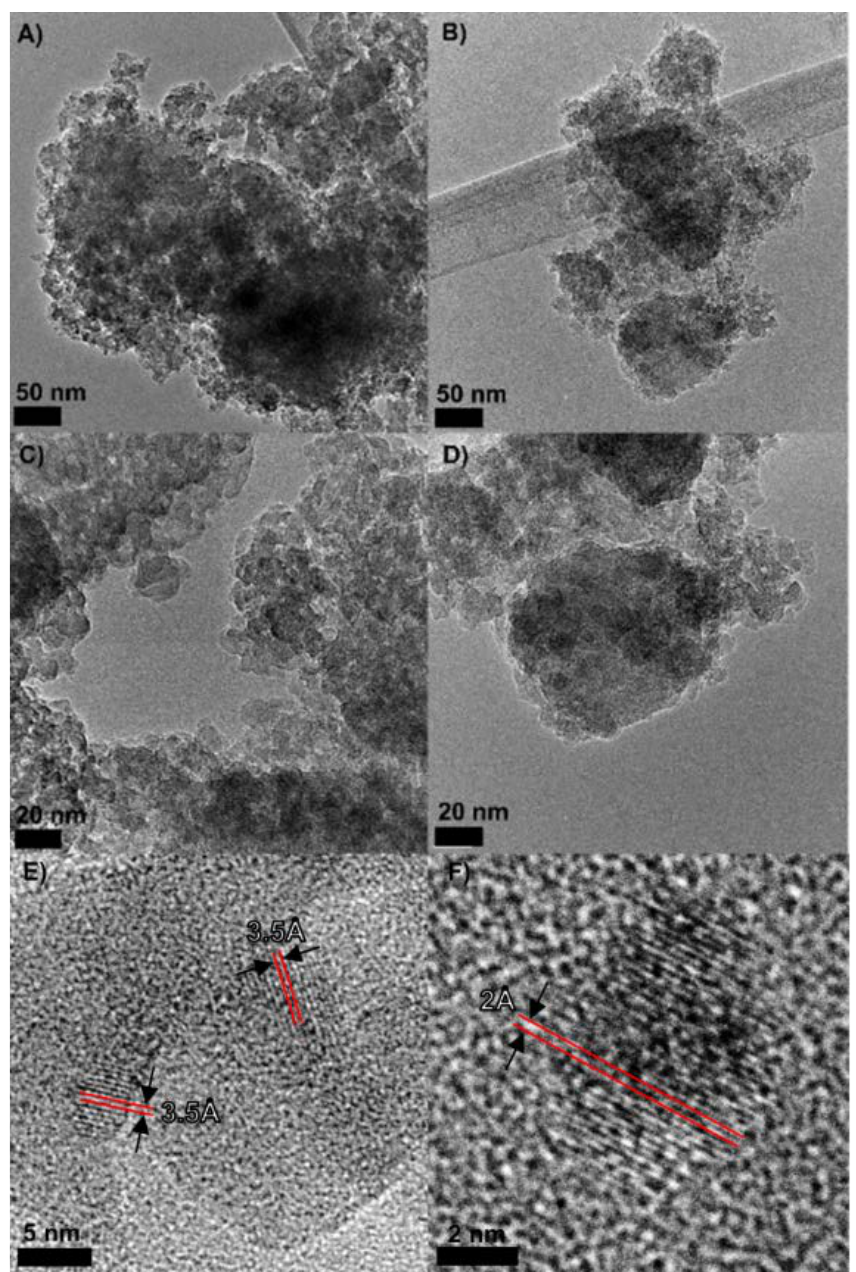
Figure 1. Representative high-resolution transmission electron microscopy (HRTEM) images obtained for the photocatalysts UCA ( A , C ), UCA–TiO 2 Au 450 °C ( B , D ), interplanar spacing of TiO 2 ( E ) and Au ( F ).